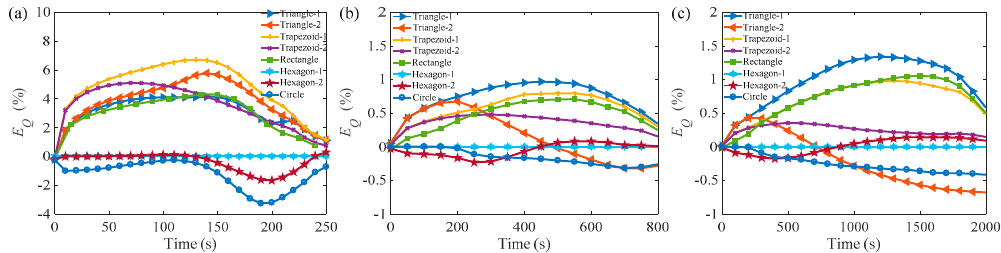
Figure 12. Enhancement ratios of energy absorption in the triangular, trapezoidal, square, hexagonal, and circular cells over time ( AR = 0.5). ( a ) Ra = 3.095 × 10 5 ; ( b ) Ra = 4.83 × 10 6 ; ( c ) Ra = 3.87 × 10 7 .